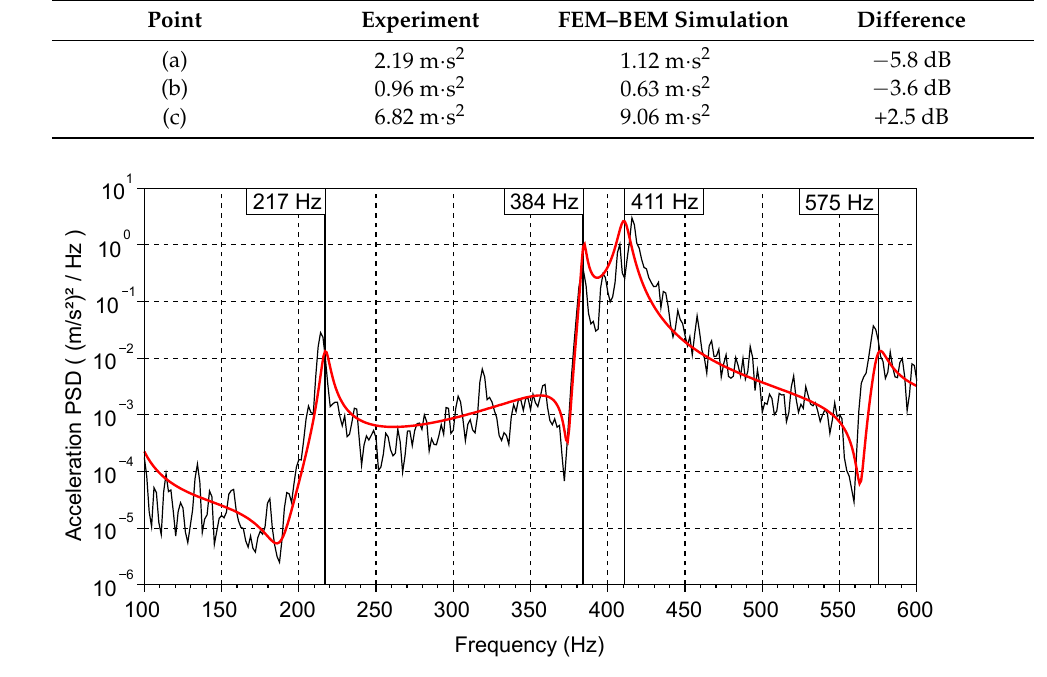
Figure 13. Zoom of Figure 12 below 600 Hz. Table 2. Interpretation of the four first simulated resonance phenomena (see Figure